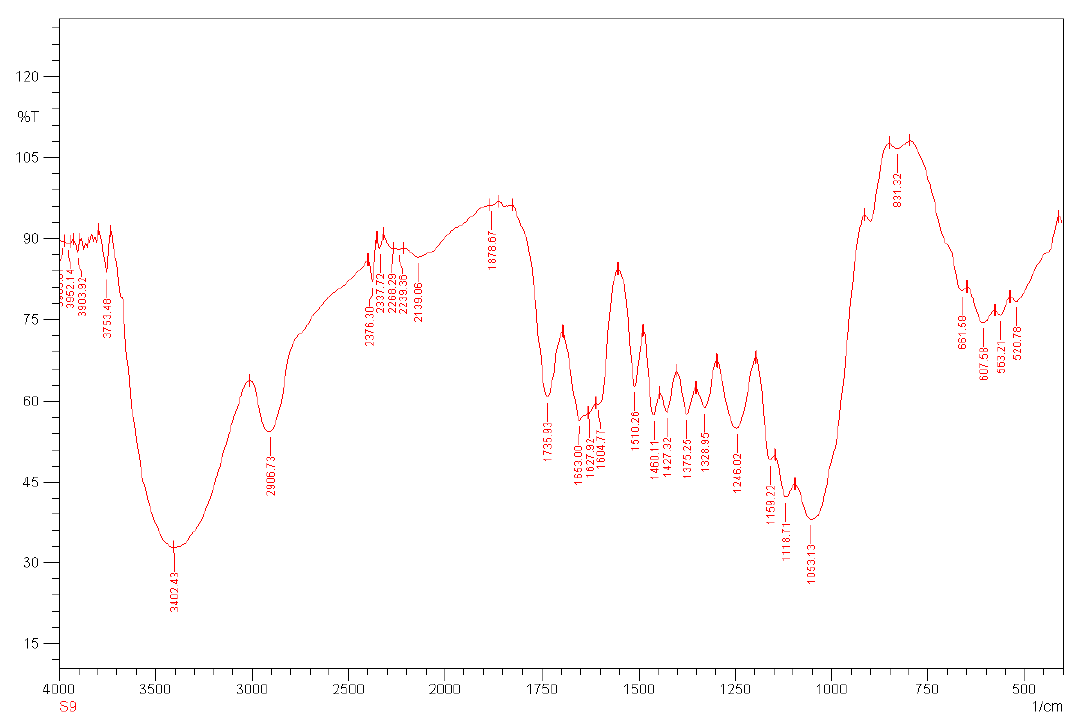
Figure 3. Transmittance spectrum of Rhizophora spp. particleboard bonded with 12% binders. Reprinted with permission from ref. [7].